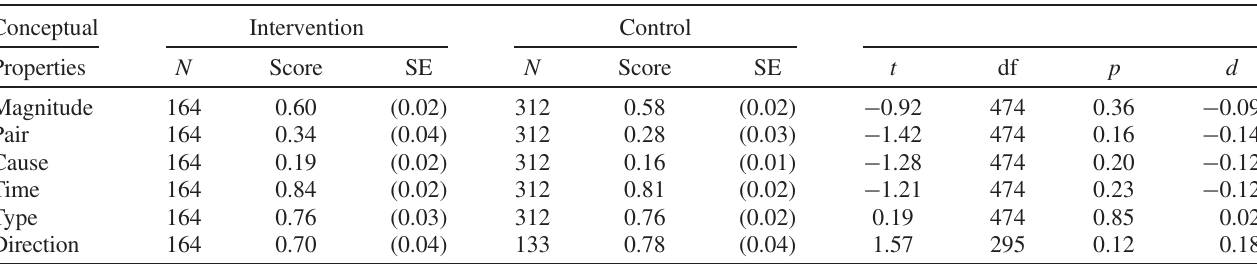
TABLE IV. Comparison of pretest scores between the two groups. Differences were not significant for any conceptual property. Conceptual Intervention Control